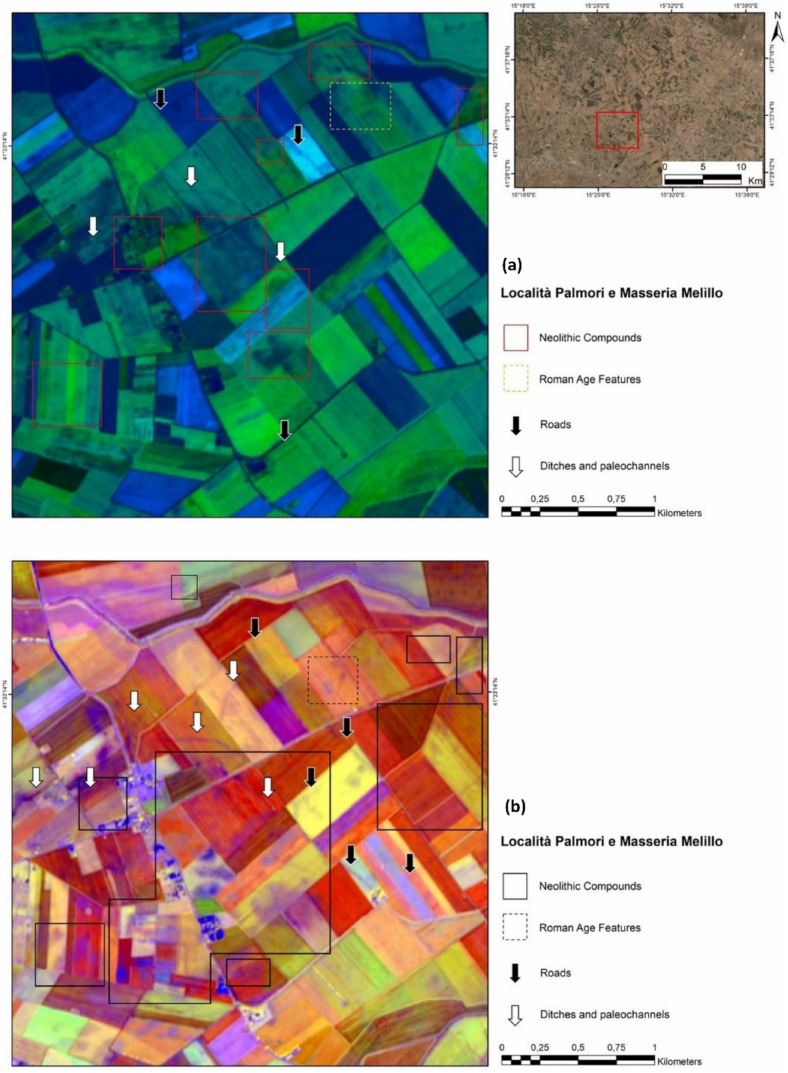
Figure 11. Identification of the features of archaeological interest, in the Palmori area, within the PCA: ( a ) PCA obtained with all the bands and indices produced, R: 2nd component, G: 10th component, B: 11th component; ( b ) PCA obtained with the images in which Spectral Unmixing has shown greater separability, R: 1st component, G: 2nd component, B: 3rd component. In the images there are archaeological sites already known from the bibliography / survey and archaeological sites not included in the national archaeological